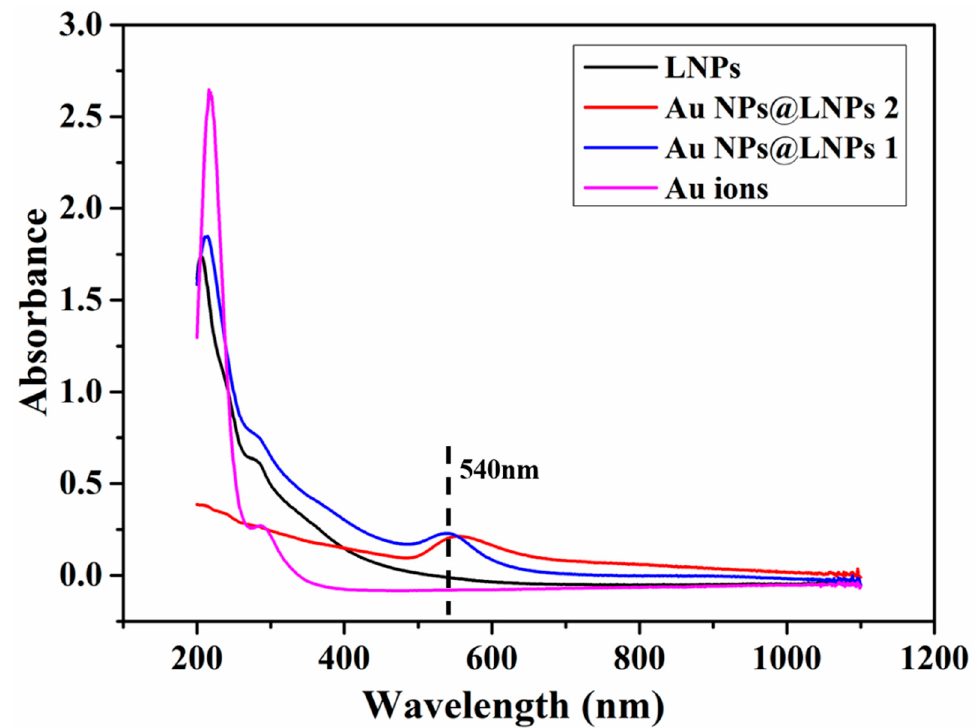
Figure 6. UV ‐ Vis spectra of the LNPs, Au ions and LNPs@AuNPs. Figure 6. UV-Vis spectra of The LNPs, Au ions and